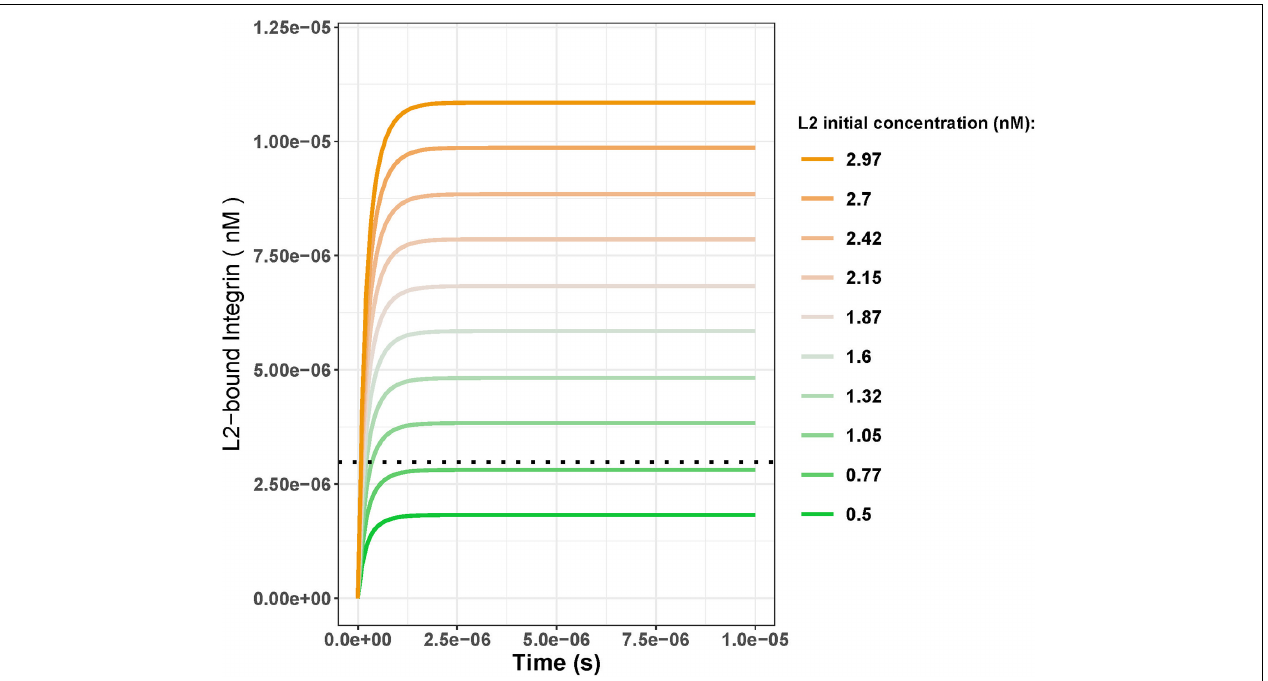
FIGURE 4 | L 2-bound integrin concentration over time with varying initial concentrations of L 2 with the initial concentration of L 1 kept constant at 0.84 nM. Black dotted line shows the day 18 steady-state concentration for L 2-bound integrins when the initial L 1 and L 2 concentrations were both 0.33 nM. Comparing the steady-state concentrations from the line plots to the black dotted line, initial L 2 concentrations greater than 0.77 nM result in the steady state of the L 2-bound integrins exceeding that of day 18 (2.98 nM). This corresponds to a fold change of 2.3 between days 18 and